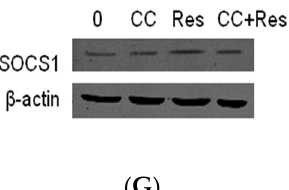
Figure 3. SOCS1 is required for resveratrol-induced suppression of MMP-2 expression induced by P. endodontalis LPS in MC3T3-E1 cells. MC3T3-E1 cells were incubated with various concentrations resveratrol (Res) for 60 min ( A ). MC3T3-E1 cells were treated with 20 µM resveratrol for the indicated time periods ( B ). SOCS1 protein levels were detected by western blot analysis. MC3T3-E1 cells were transfected with si-control or si-SOCS1. SOCS1 expression was detected by real-time PCR ( C ) and western blot ( D ). MC3T3-E1 cells were transfected with si-control or si-SOCS1. Transfected cells were stimulated with 10 mg L − 1 P. endodontalis LPS for 24 h, or not, in the absence or presence of 20 µ M resveratrol for 1 h, and then MMP-2 mRNA expression and collagenase activity were detected by real-time PCR ( E ) and gelatin zymography ( F ), respectively. HT1080 medium indicates conditioned medium collected from HT1080 (human fibrosarcoma) cells that was used as a positive control. U is the atomic mass unit. 1 Ku is approximately equal to 1 KDa. ( G ) MC3T3-E1 cells were pretreated with 20 µ M resveratrol for 1 h, or not, in the absence or presence of 10 µ M Compound C (CC) for 30 min. SOCS-1 protein levels were detected by western blot analysis. * p < 0.05 as compared to the control group.